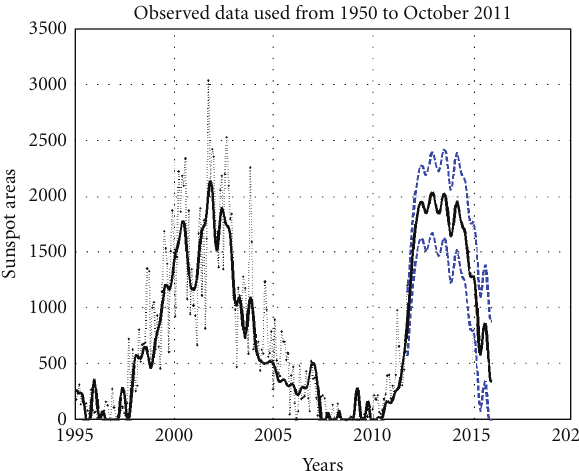
Figure 7: SC24 shape prediction for monthly mean sunspot areas variation. Dotted line demonstrates the real data. Dashes show the one sigma intervals. Solid is the modeled